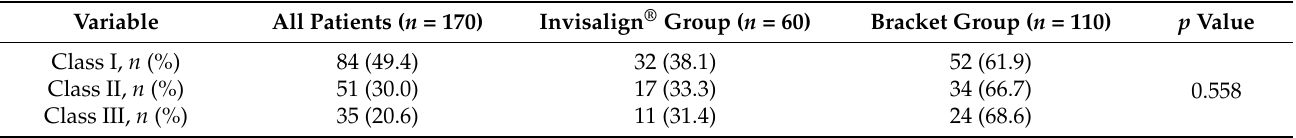
Table 3. Sagittal skeletal relationship of patients, stratified by orthodontic device (Invisalign ® or bracket) ( n = 170).